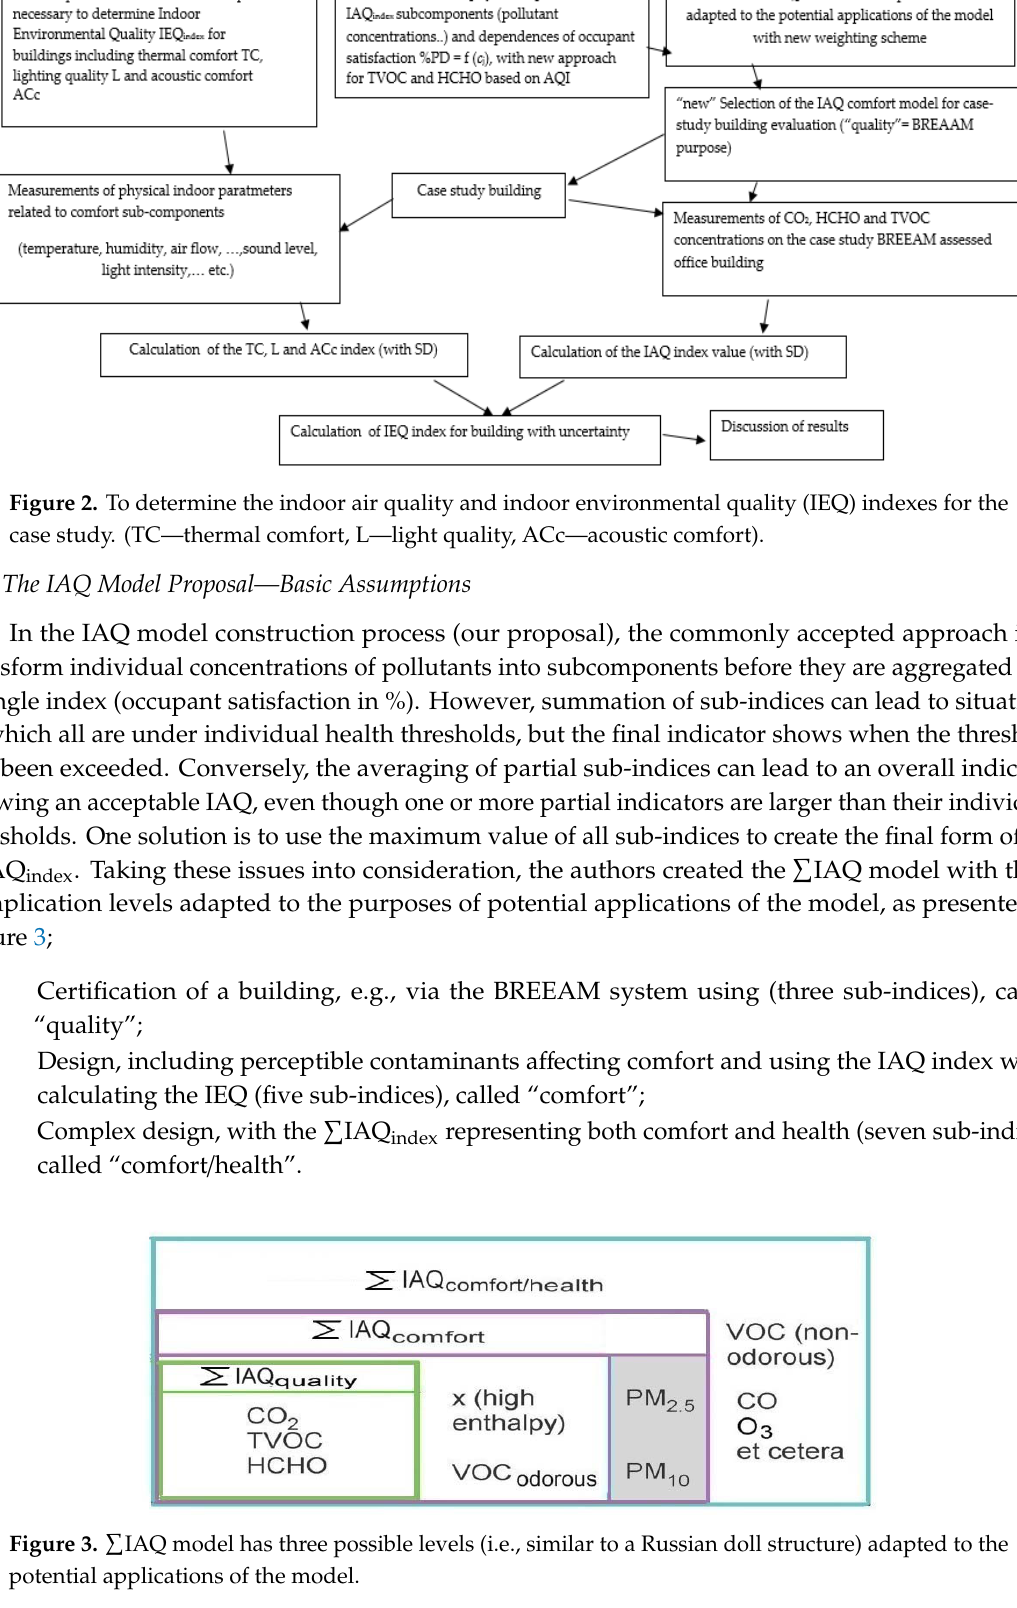
Figure 3. ∑ IAQ model has three possible levels (i.e., similar to a Russian doll structure) adapted to the potential applications of the model.